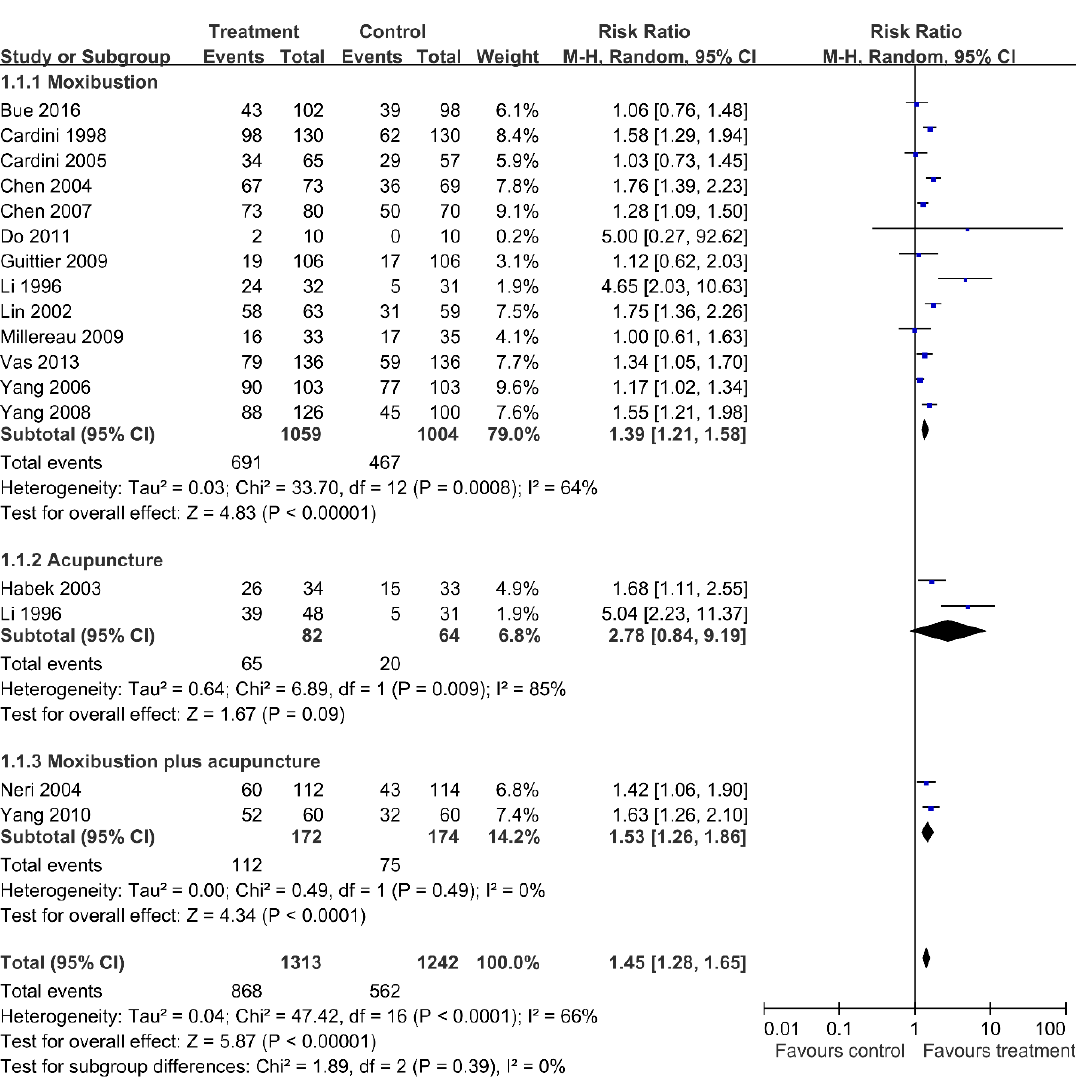
Figure 4. Forest plot of each comparison: Acupuncture-type interventions versus Control; Outcome: Cephalic presenta- tion.